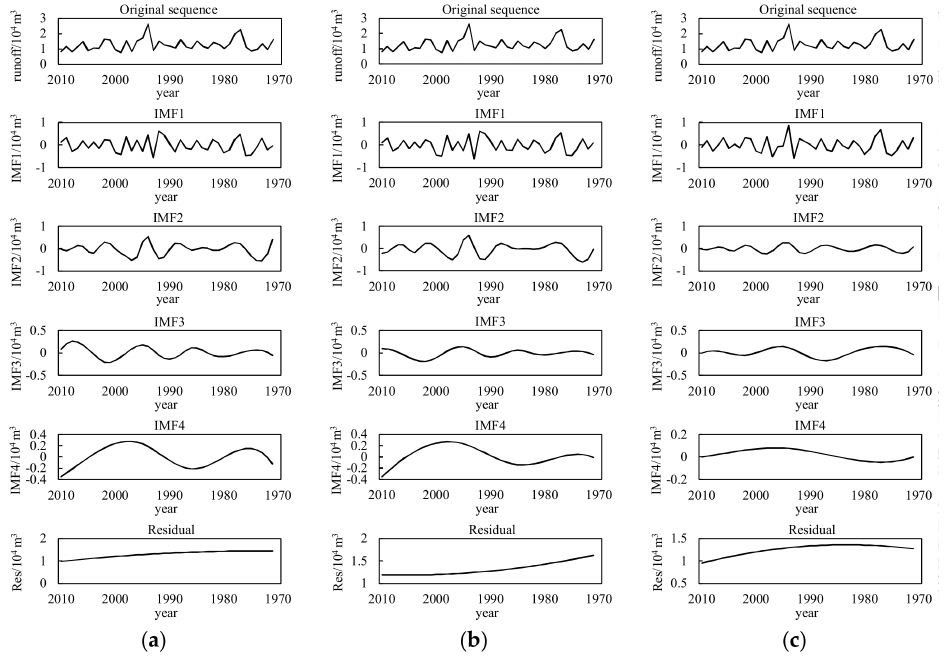
Figure 2. The decomposition results of runoff series based on ( a ) standard deviation (SD) criteria; ( b ) G. Rilling (GR) criteria; and ( c ) the method of tracking energy differences (MTED) at the Suide